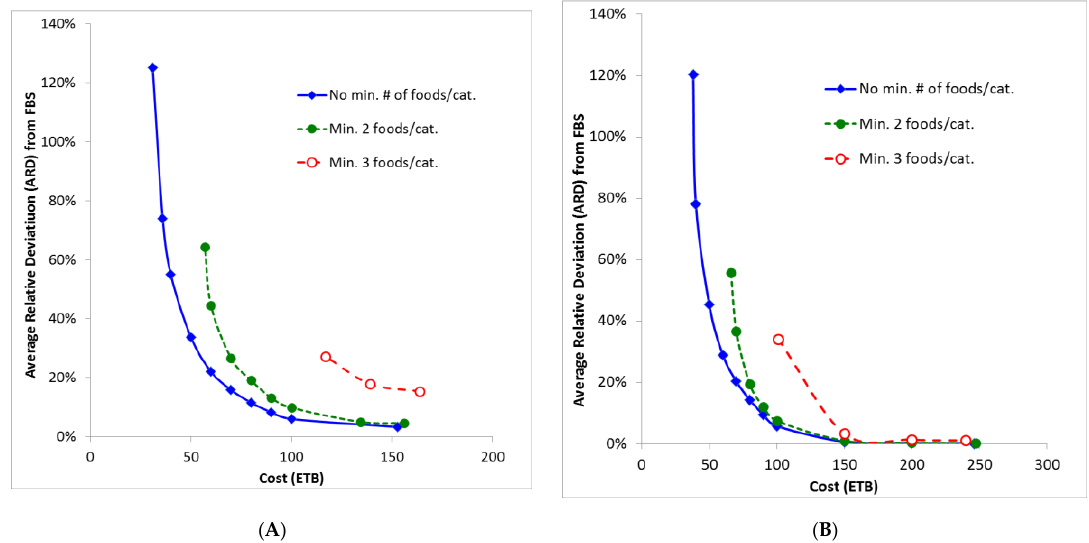
Figure 1. Average relative deviation (ARD) of the rural (Panel A ) and urban (Panel B ) food baskets compared with Food Balance Sheets (FBS) [33] depending on the maximum cost imposed; ETB: Ethiopian Birr.